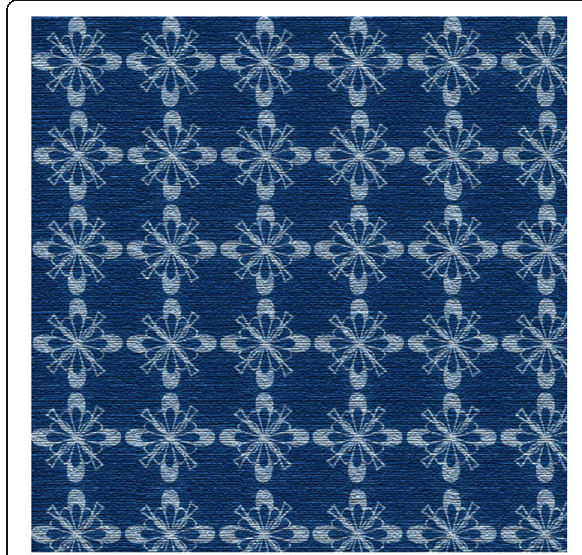
Fig. 5 Computer digital simulation tie-dye pattern. (The second is to